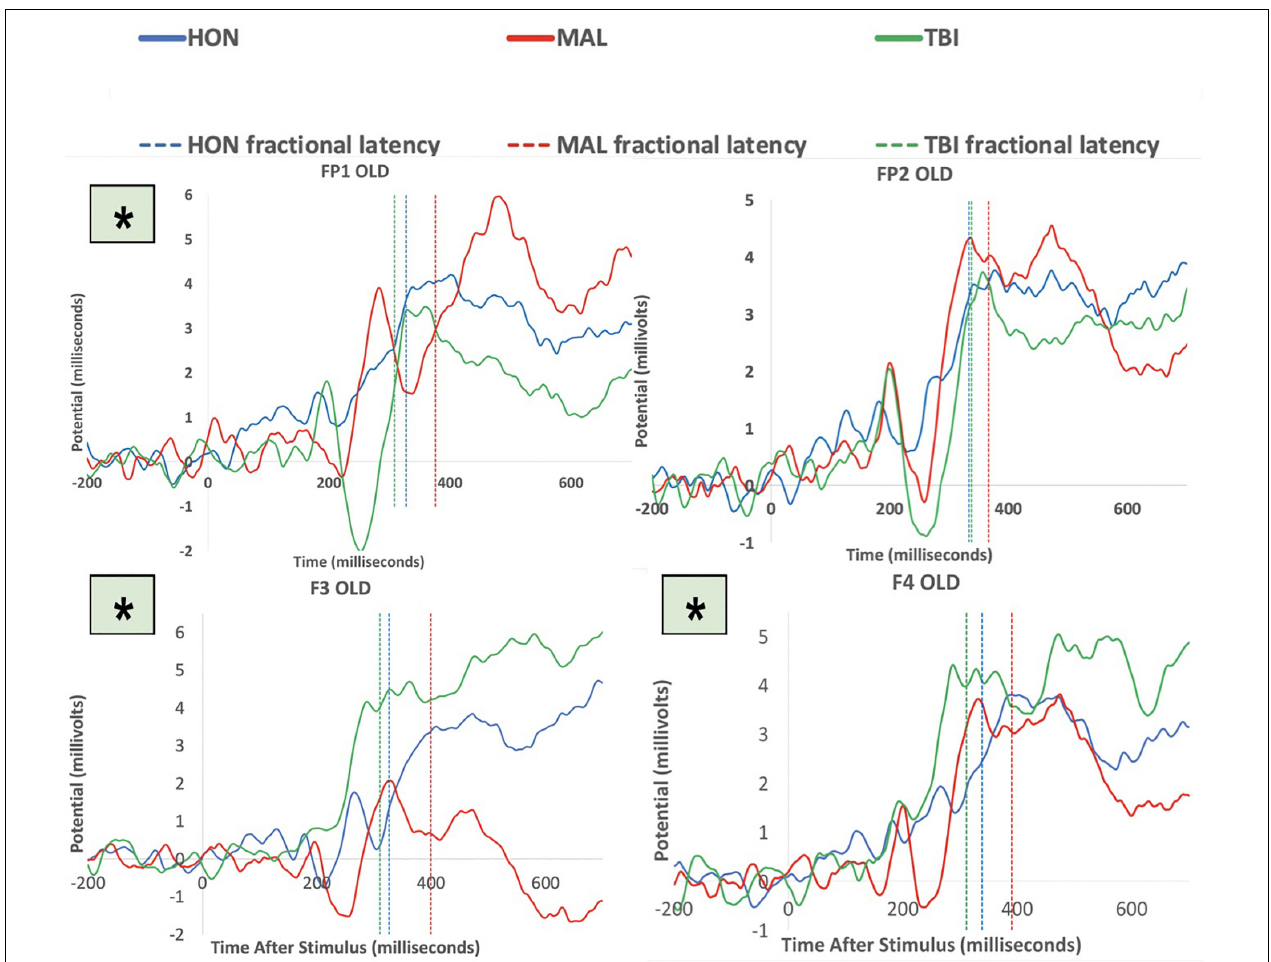
FIGURE 3 | Group averaged responses during Old items at the electrodes FP1, FP2, F3, and F4. Solid lines represent grand average of ERP responses of honest subjects (blue), malingering subjects (red), and TBI subjects (green) at each electrode site. Dashed lines represent the averaged fractional peak latencies of each group with the same corresponding colors. Asterisks indicate significant results at the electrode. Note that all significant group differences between MAL and true TBI were during memory recognition of studied